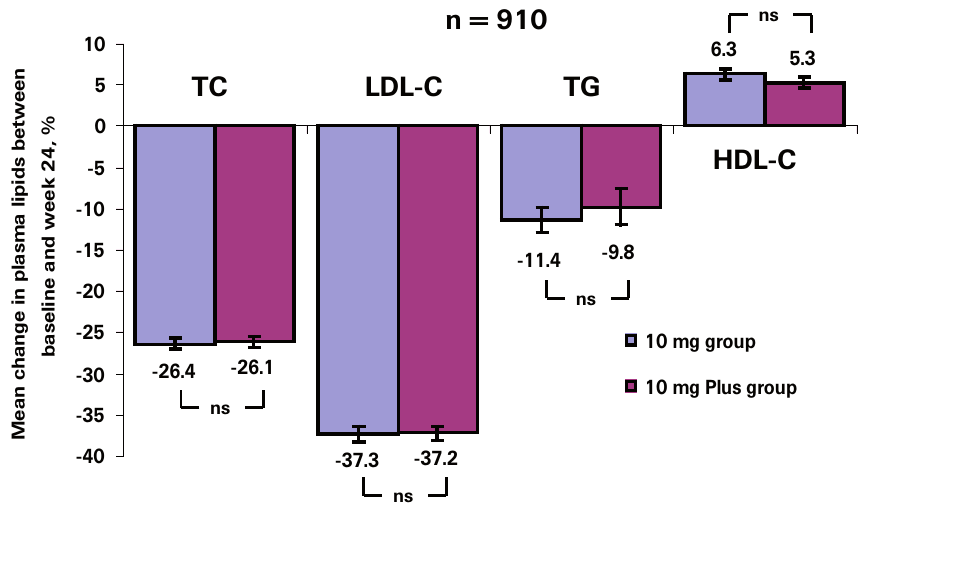
Figure 2 Mean percentage change in plasma lipids between base- line and week 24 in patients treated with rosuvastatin alone (10 mg group) or in combination with compliance enhance- ment tools (10 mg Plus